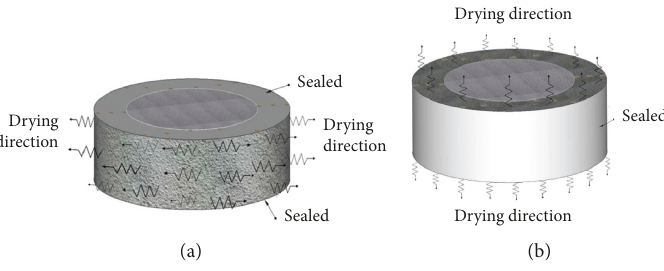
Figure 4: Free ring specimen with DEMEC. (a) Sealed on top (and bottom) and (b) sealed on the outer circumferential surface.